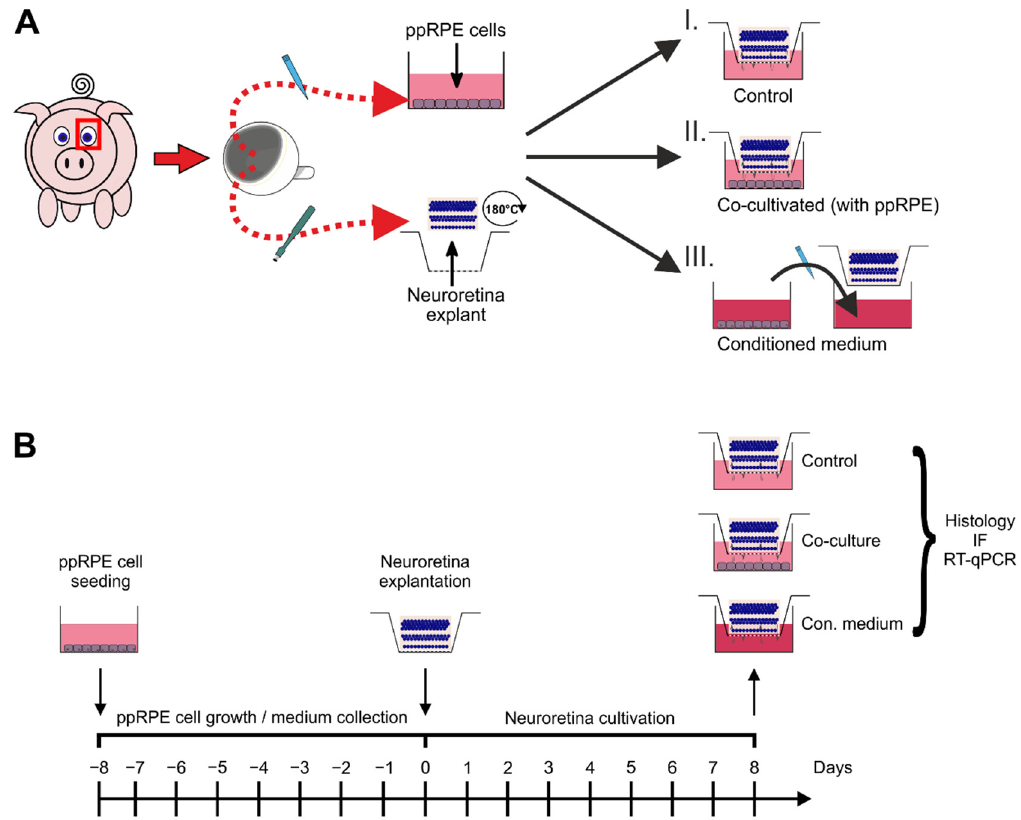
Figure 1. Graphical outline of technique and study design. ( A ) Schematic overview of the three assessed groups named control, co-culture, and conditioned medium. Fresh porcine eyes were used to isolate primary porcine RPE cells (ppRPE). Neuroretina explants were obtained from the visual streak. Single cultured neuroretina explants cultured for eight days served as control (I.). In addition, a co-cultivation with ppRPE cells and neuroretina was performed (II.) and a neuroretina group was cultivated with conditioned ppRPE medium (III.). ( B ) ppRPE cells were seeded on wells eight days before neuroretina explants were prepared. On day zero, neuroretina explants were added to a ppRPE cell feeder layer or cultivated with conditioned ppRPE medium. On day eight, samples from all three groups were collected for histology, immunofluorescence (IF), and RT-qPCR